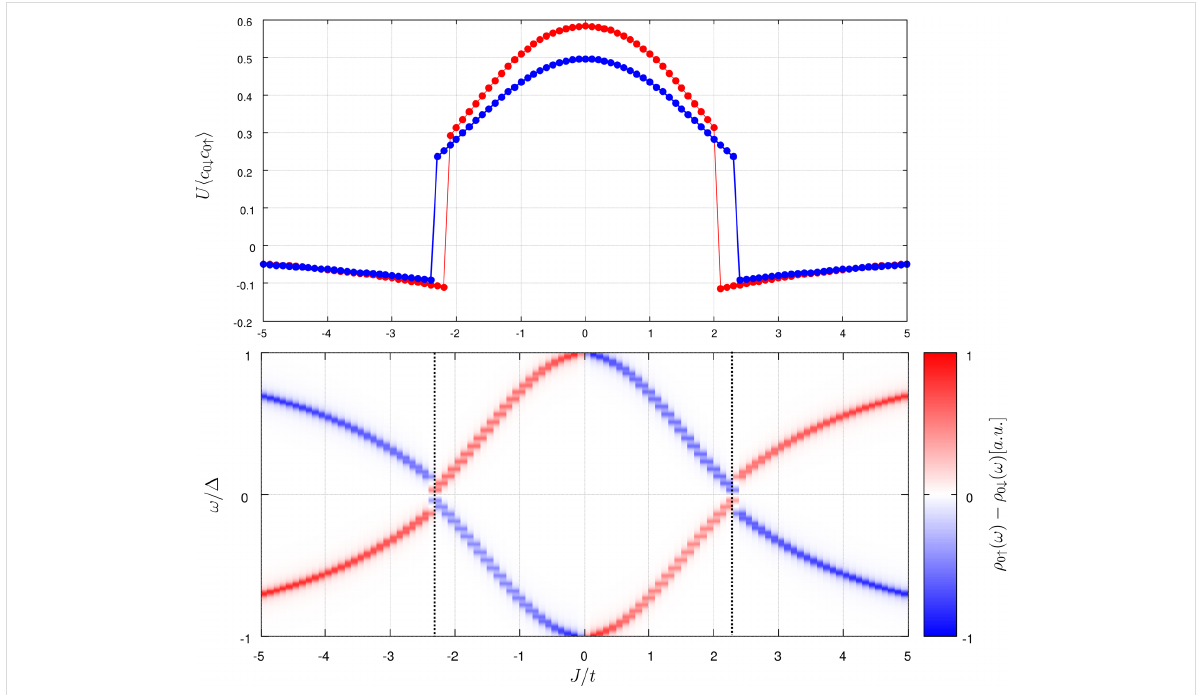
Figure 1: The local order parameter obtained at zero temperature for weak λ / t = 0.1 (red line) and strong spin–orbit coupling λ / t = 1 (blue line). The bottom panel shows the energies and magnetic polarization ρ 0 ↑ ( ω ) − ρ 0 ↓ ( ω ) of YSR states obtained in the weak-coupling limit λ / t = 0.1.